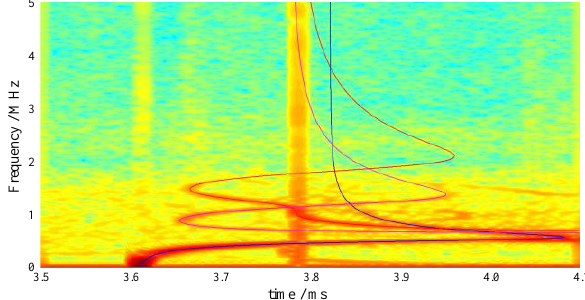
Figure 12. Time-frequency joint spectrum of the free surface velocity of bar 04.